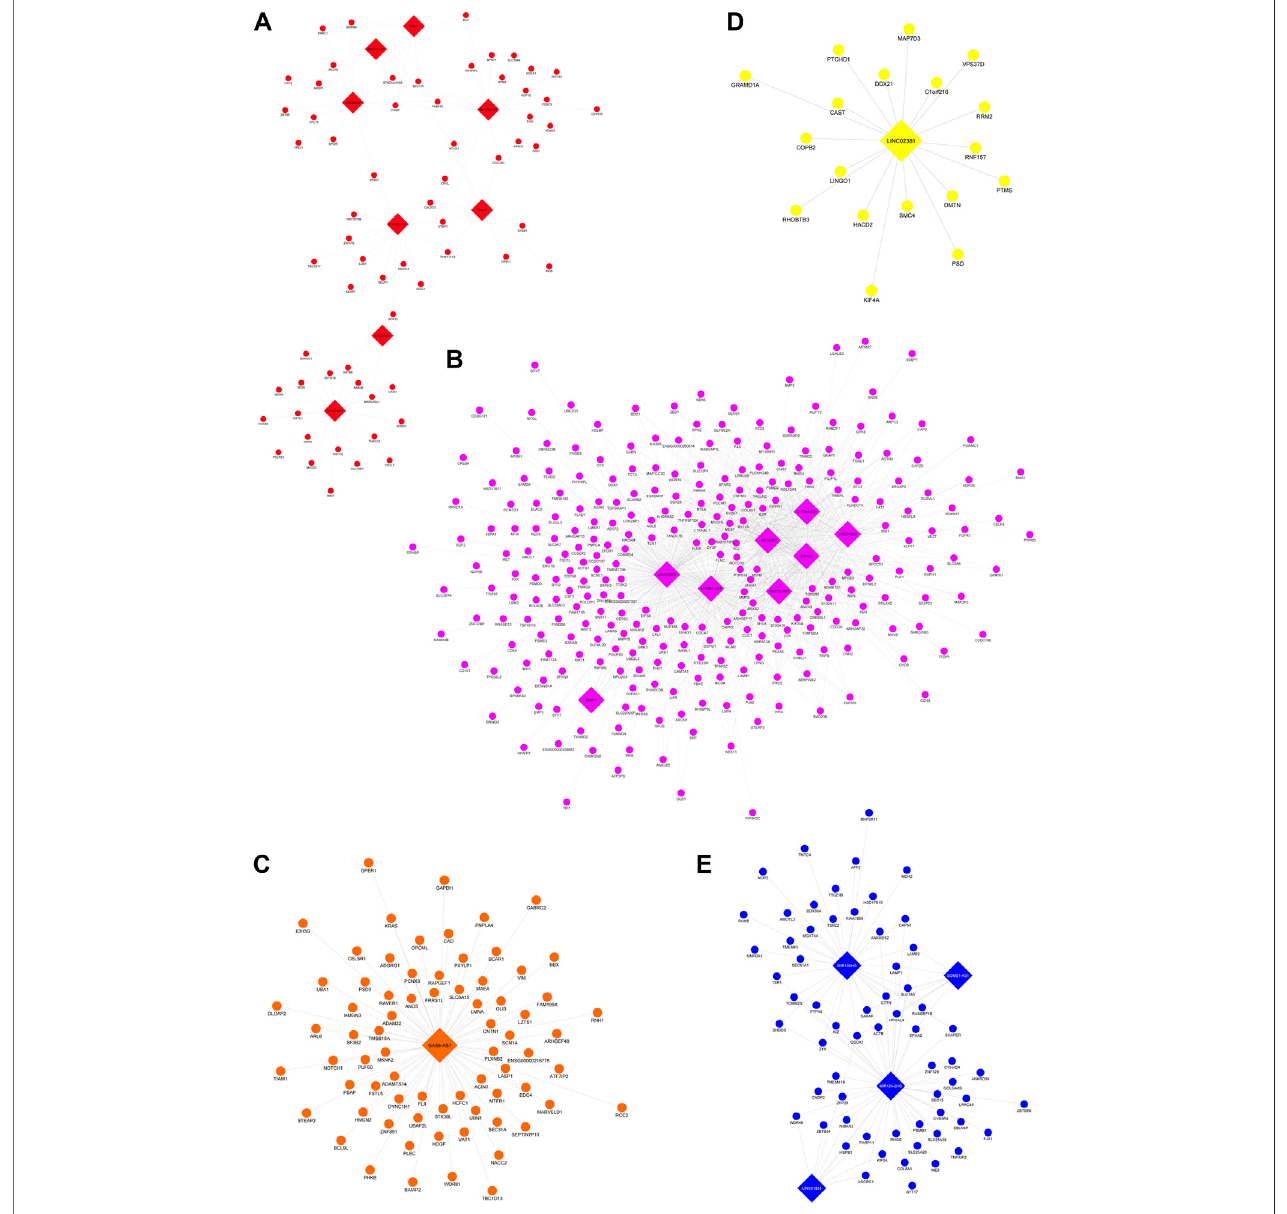
FIGURE 3 | Separated lncRNA-mRNA subnetworks of fi ve key modules. In the network, nodes representing genes and edges representing co-expression connections between them, mRNAs are circle nodes while lncRNAs are diamond shaped. Each subnetwork corresponds to a module: (A) Module 1 (red nodes), (B) Module 4 (pink nodes), (C) Module 5 (orange nodes), (D) Module 7 (yellow nodes), and (E) Module 10 (blue